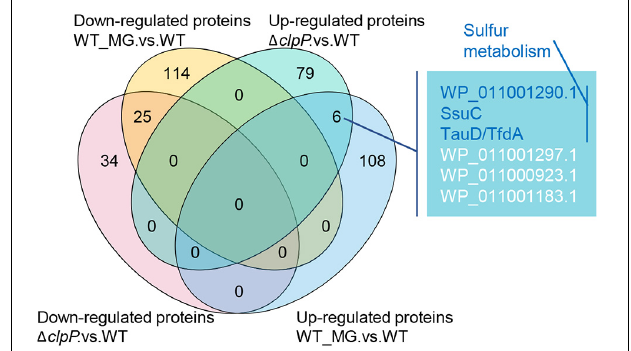
FIGURE 4 | Differentially expressed proteins shared by (cid:49) clpP versus wild-type (WT) and WT_MG versus WT.